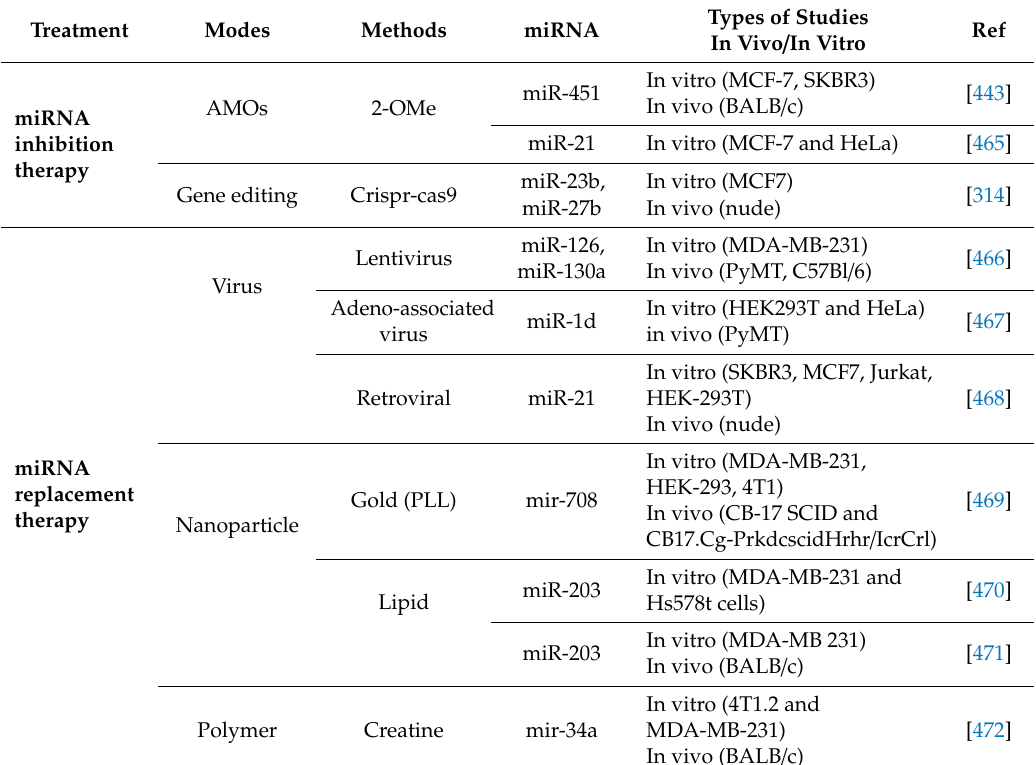
Table 2. Di ff erent types of miRNA-based